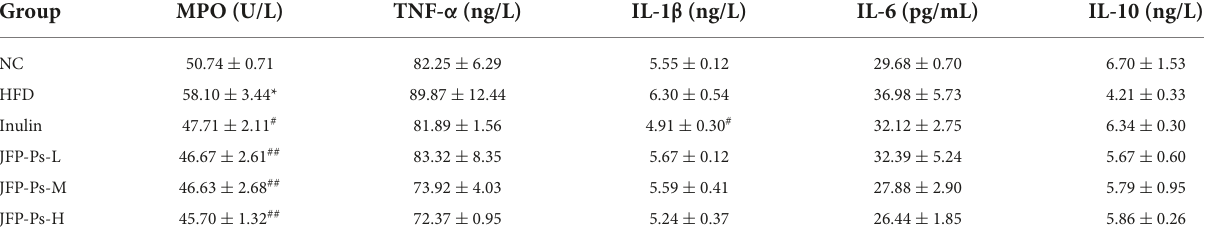
TABLE 3 Effect of JFP-Ps on inflammation-related factors in the colon of obese rats.